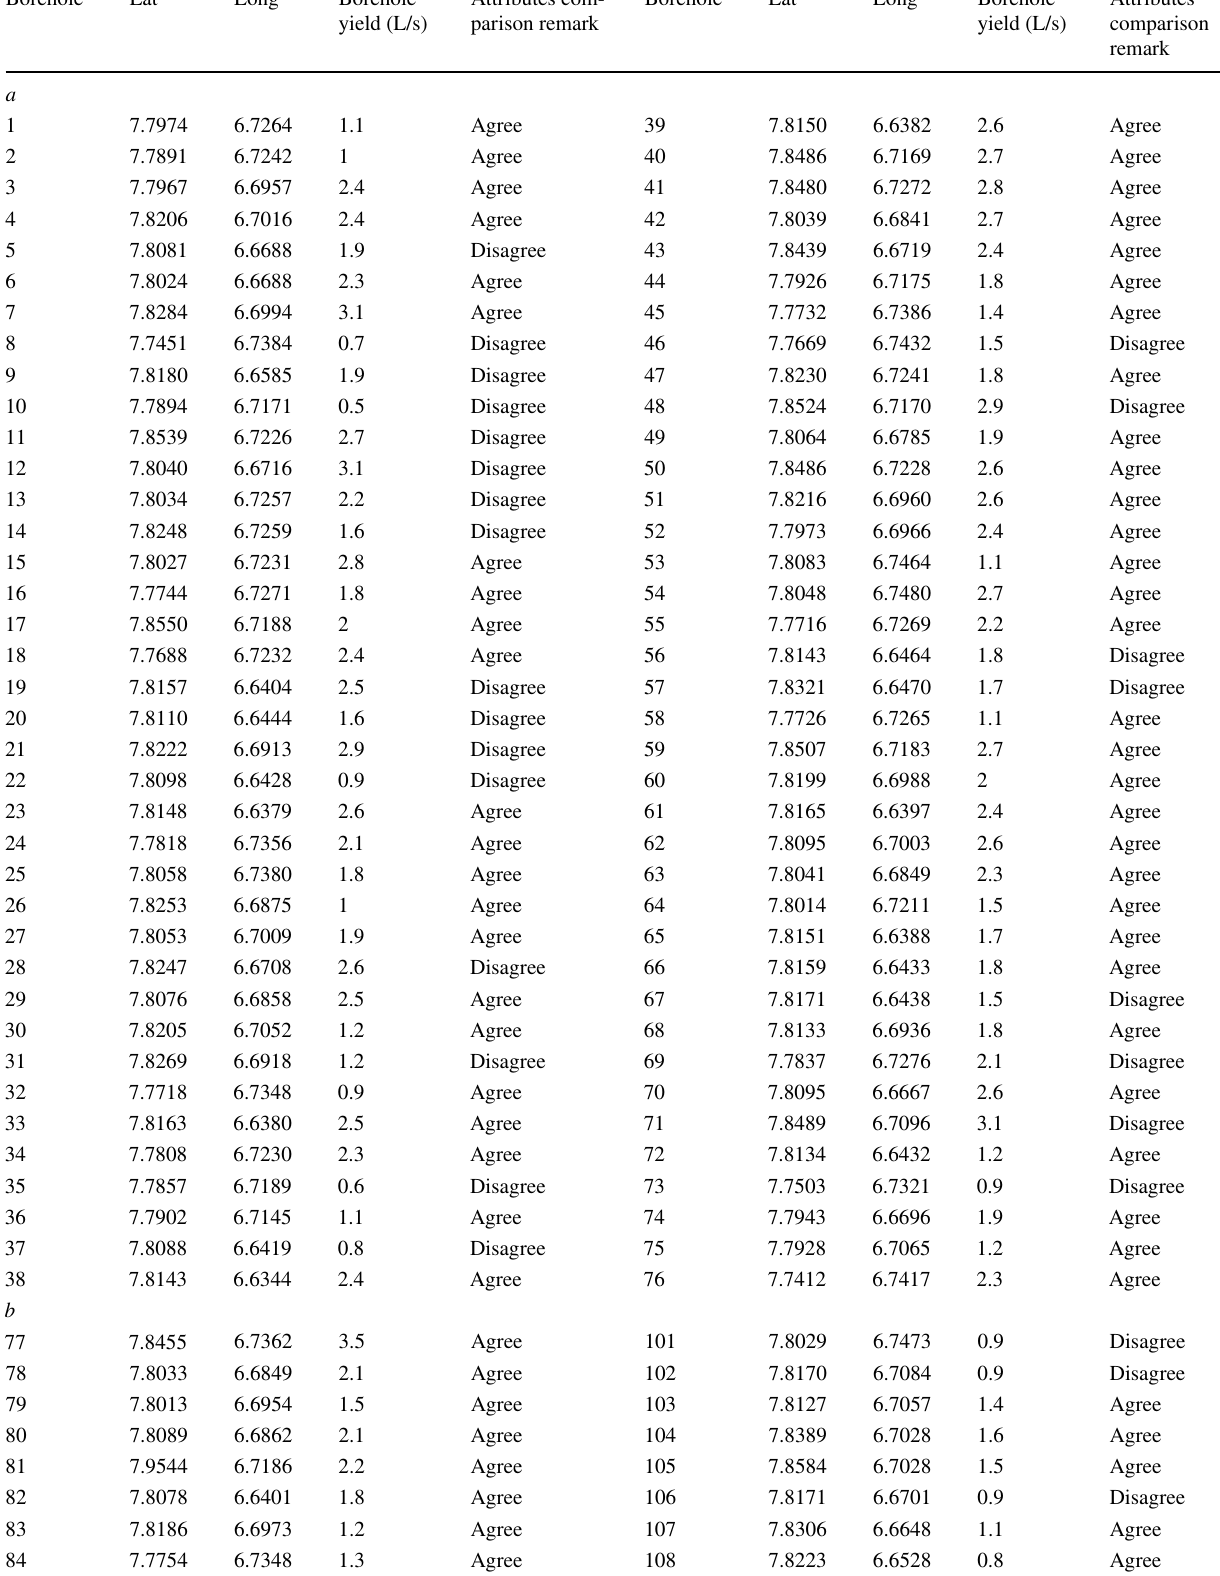
Table 4 The spatial attribute comparative scheme qualitative result Borehole Lat Long Borehole